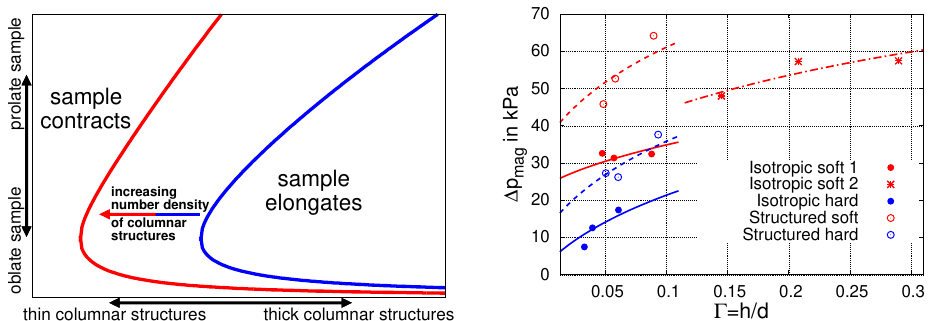
Figure 6. Left side : Part of a phase diagram as obtained in [32]. Whether an MAE sample contracts or elongates in direction of the applied magnetic field crucially depends on the sample form (oblate or prolate), the thickness of the columnar microstructure and number density of such structures in the sample, i.e., the overall amount of magnetizable particles. Right side : Systematic comparison between theory and experiment allowed for identifying the contribution from macroscopic sample shape and microscopic particle structure to the magnetically induced stress in confined MAE